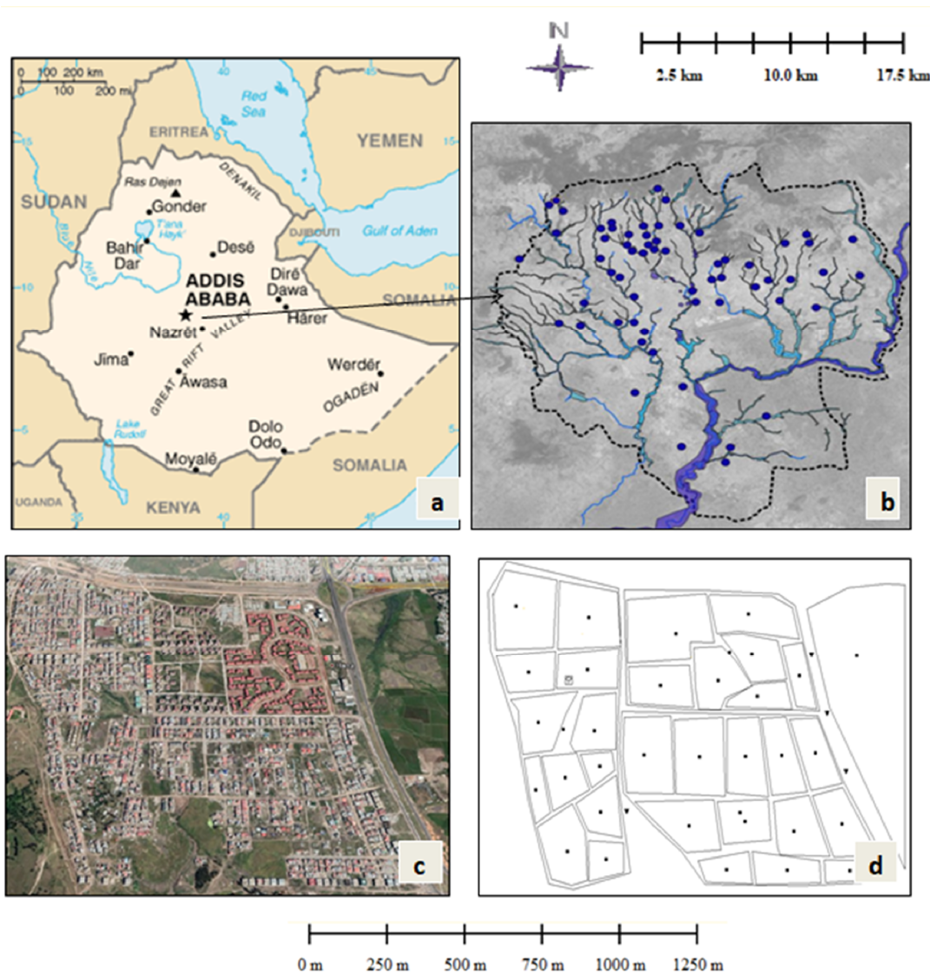
Figure 1. Study Area: map of Ethiopia ( a ); Map of Addis Ababa City showing recorded floods with blue points ( b ); study area condition showing flood prone areas in red ( c ); and proposed drainage system plan black points showing sub-catchment centroids ( d ).